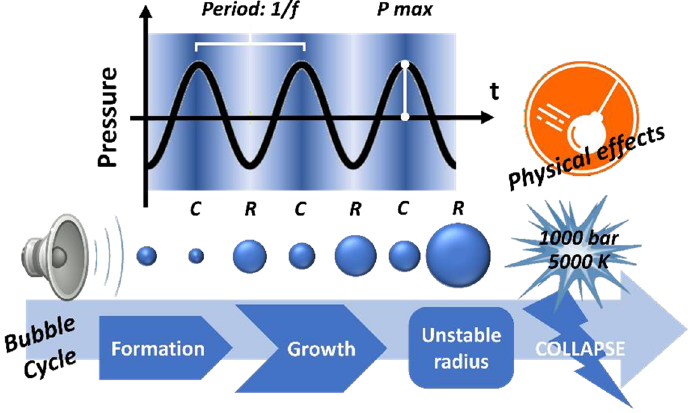
Figure 2. General representation of the acoustic cavitation phenomena.